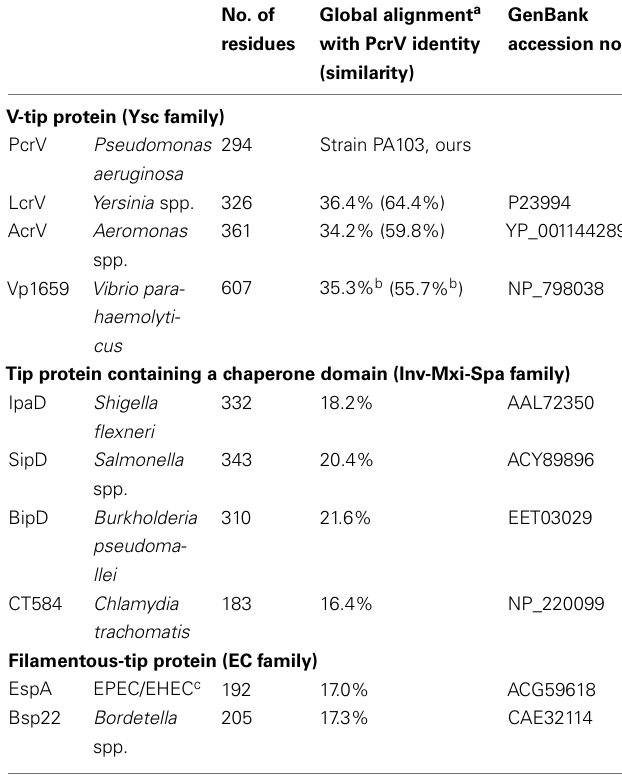
Table 1 | Needle-tip proteins of type III secretion